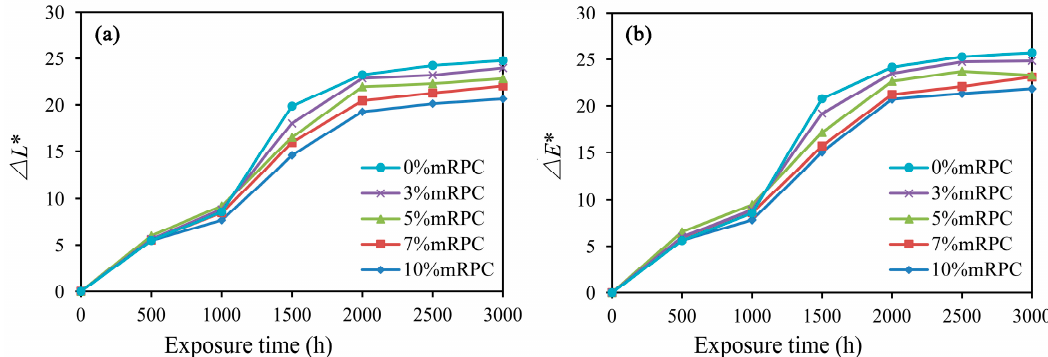
Figure 11. Effect of the duration of UV-accelerated aging treatment on the surface color of the composite ( a )  L * (luminescence); ( b )  E *